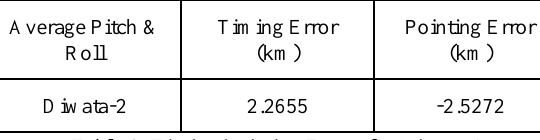
Table 8. Timing/Pointing Errors for Diwata-2